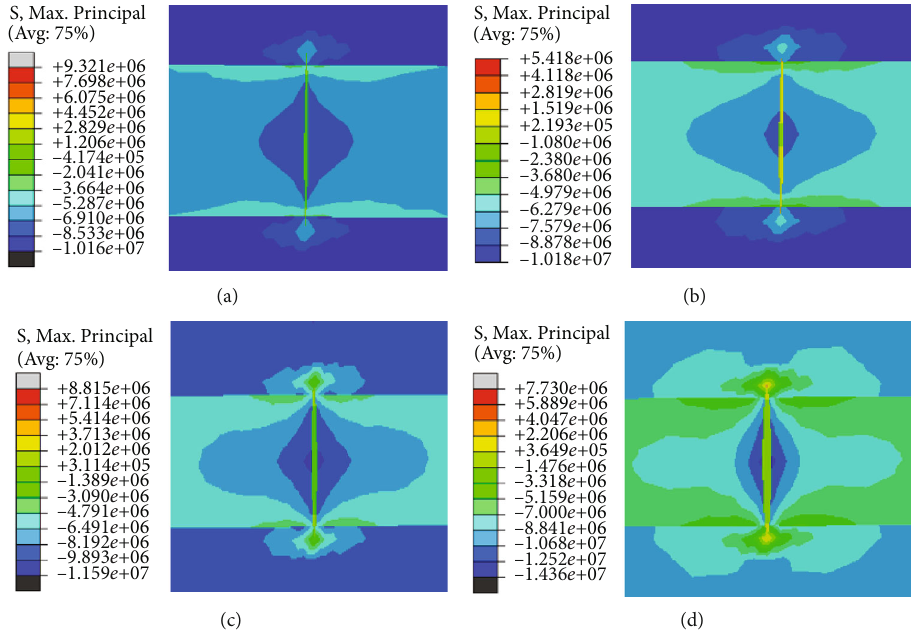
Figure 14: E ff ect of viscosity of fracturing fl uid on the development of hydraulic fracturing height at 50 time-steps for di ff erent fracturing liquid ’ s viscosities: (a) 0.01 Pas, (b) 0.1Pas, (c) 5Pas, and (d) 20 Pas.